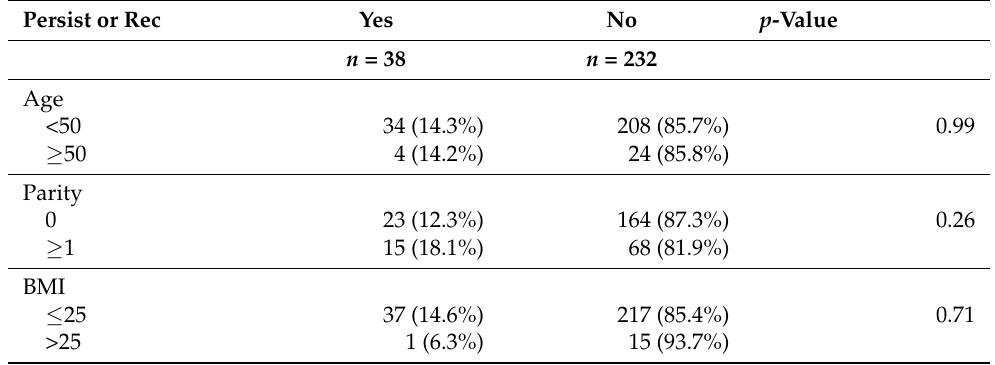
Table 2. Comparison of baseline characteristics between the recurrence and nonrecurrence